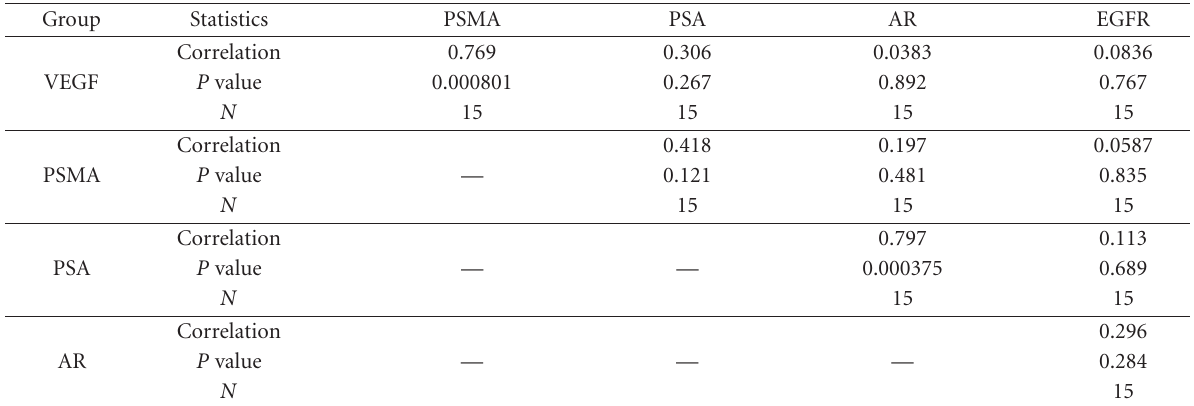
Table 2. Correlation ∗ between marker